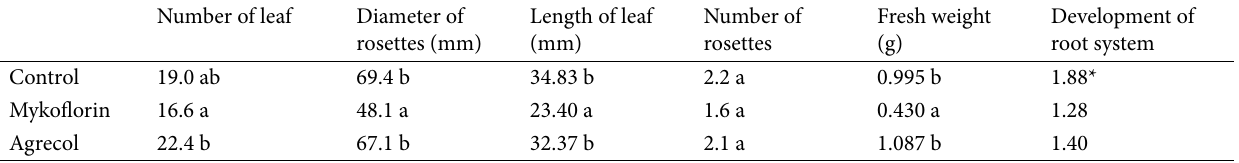
Table 2 Effect of mycorrhization on quality parameters of Primula farinosa plants. Number of leaf Diameter of rosettes